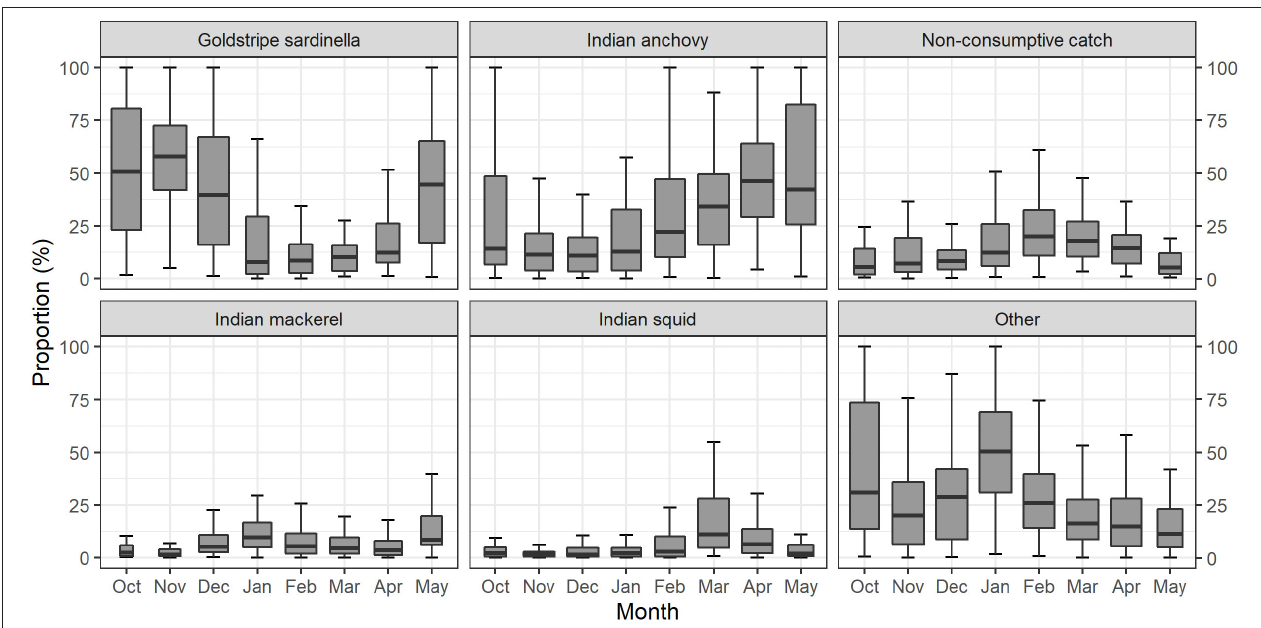
FIGURE 3 | Kyeintali purse seine fishing fleet landings data. Monthly mean proportion of yield (kg) per haul from the logbook landings data grouped by the top four most landed species, non-consumptive catch grouping and all additional landed species grouped as “Other” (see Supplementary Table 1 for full list).